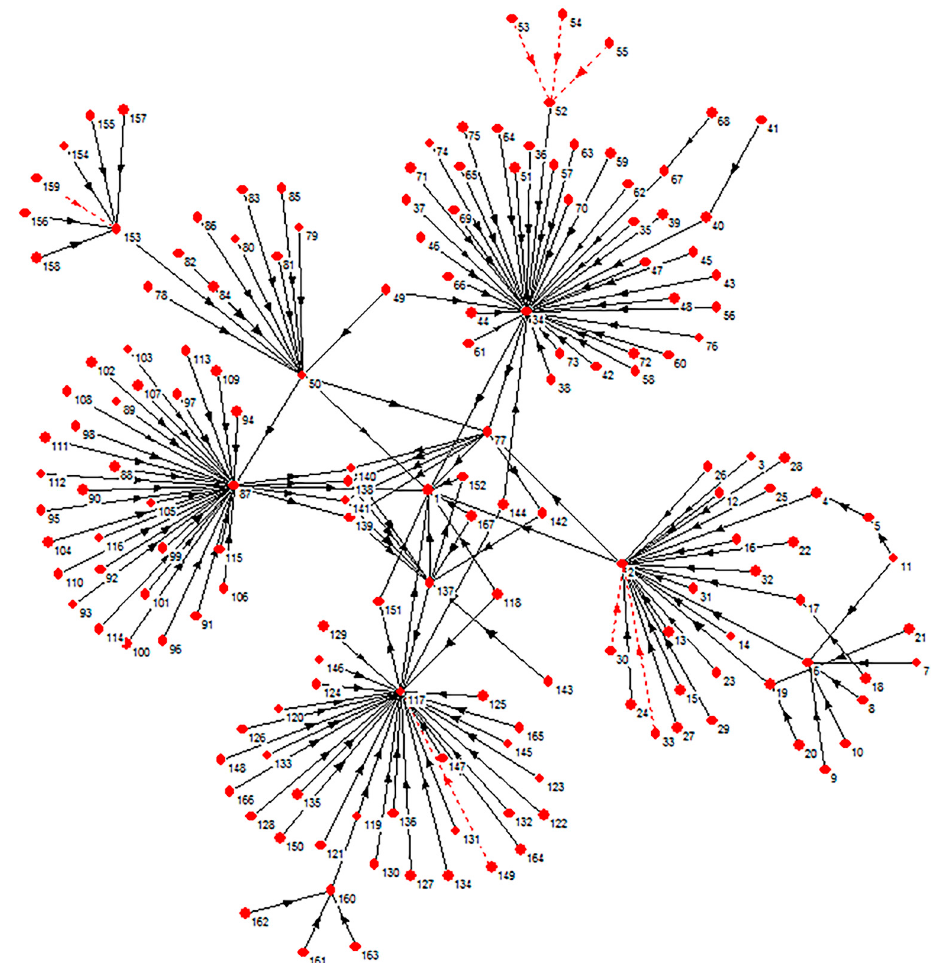
Figure 6. Basic structure of the FCM Source : Carlucci et al. (2014: 1849).